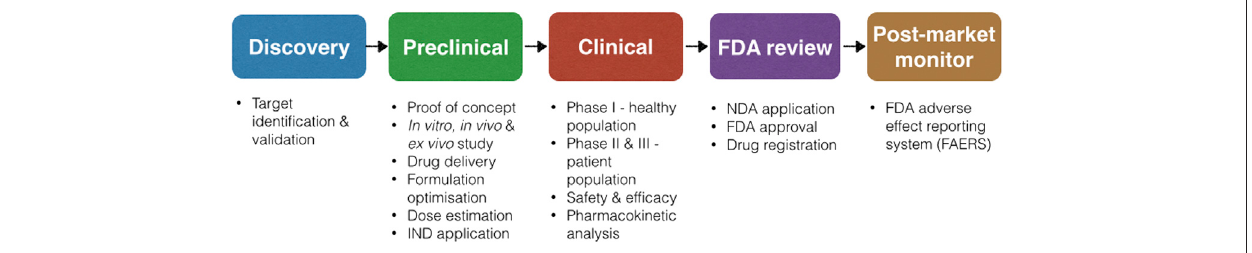
Frontiers in Nanotechnology |